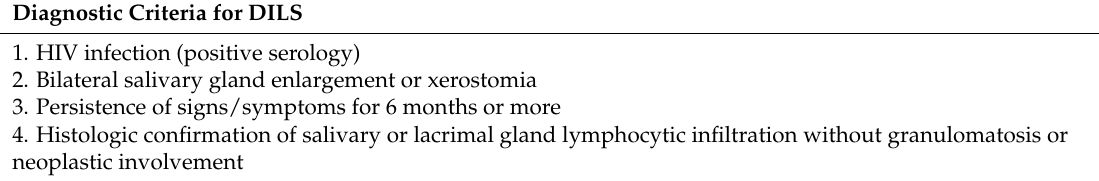
Table 3. Diagnostic criteria for DILS (diffuse infiltrative lymphocytosis syndrome), suggested by Itescu et al. (requires all criteria)